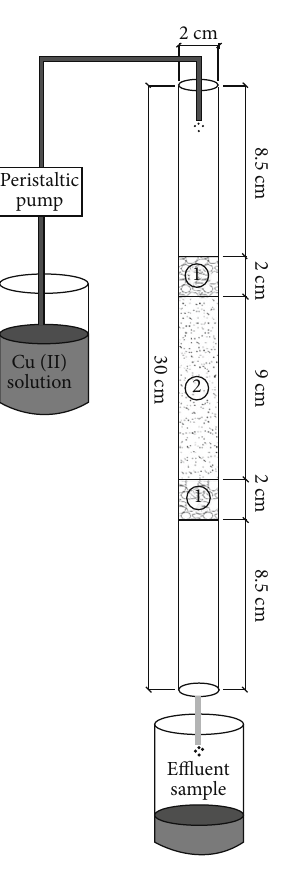
Figure 2: Sketch of fi xed-bed column device ( ① : 2 cm thick quartz sand-packed layer; ② : 9 cm thick SP-SBC-packed layer). Table 2: Some properties of SBC and